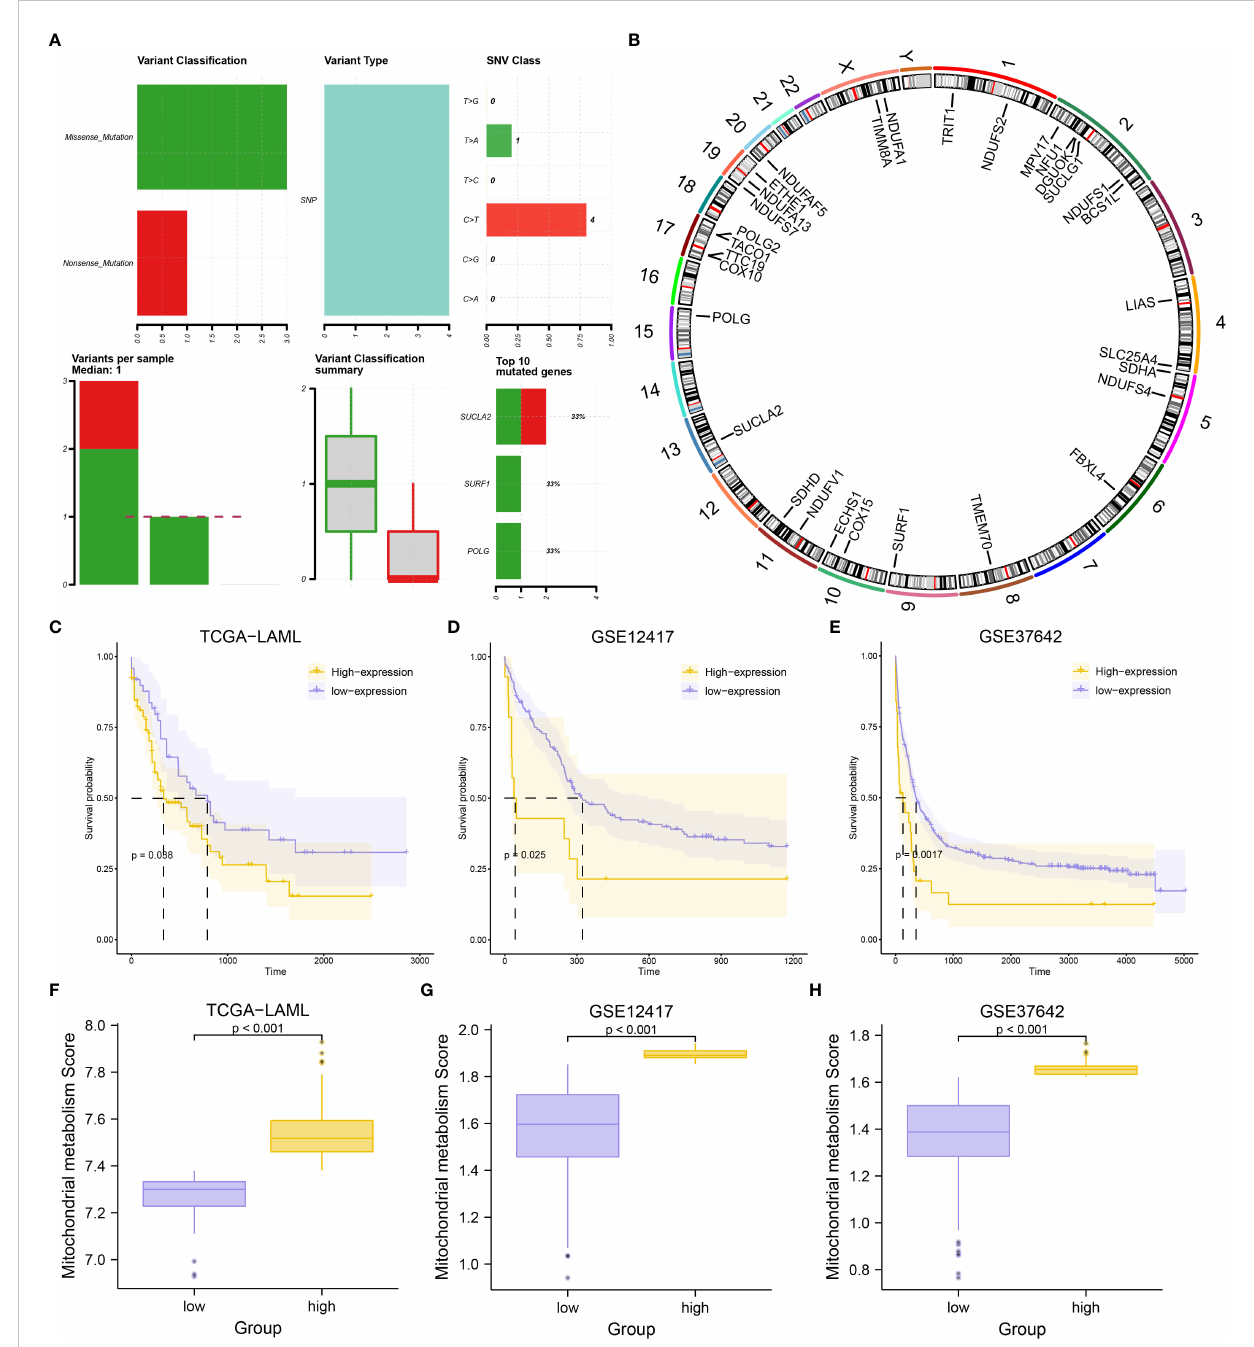
FIGURE 2 Mutational analysis of MMRGs in AML patients and construction of MMs. (A) The mutational landscape of MMRGs in AML. (B) Localization of MMRGs on chromosomes. (C-E) KM curves for the TCGA-LAML dataset (C) , GSE12417 dataset (D) , and GSE37642 dataset (E) grouped by high and low MMs. (F-H) Comparison of MMs between high- and low-MMs groups in the TCGA-LAML dataset (F) , GSE12417 dataset (G) , and GSE37642 dataset (H)